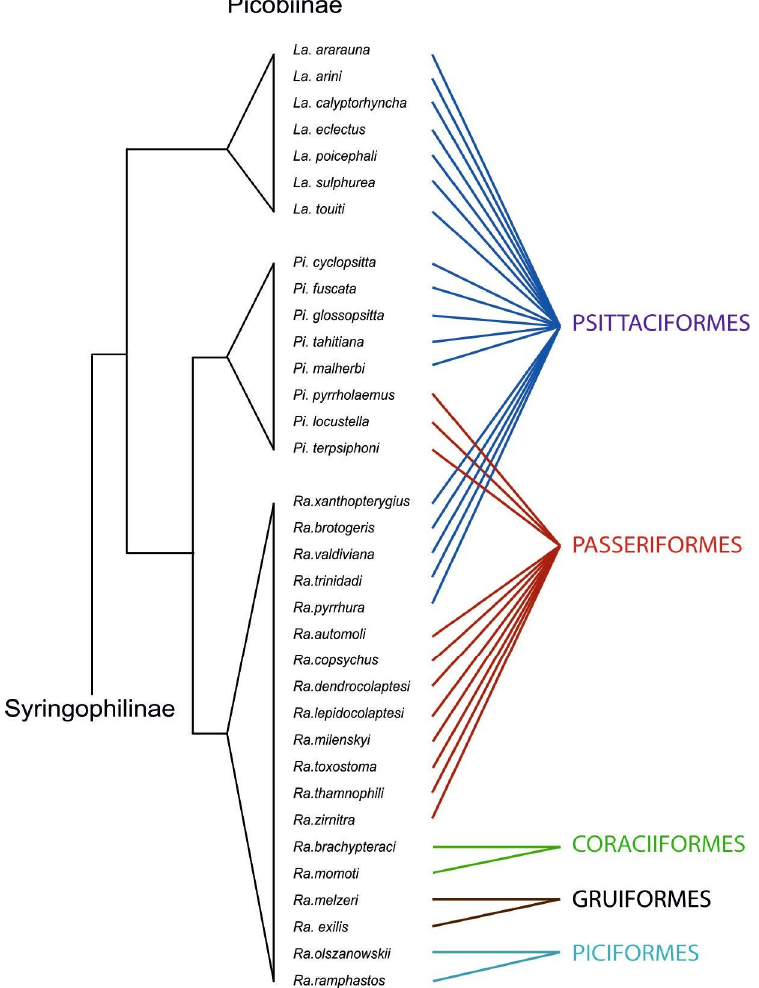
Figure 5. Host association of the species in the particular genera of the subfamily Picobiinae recorded from parrots.